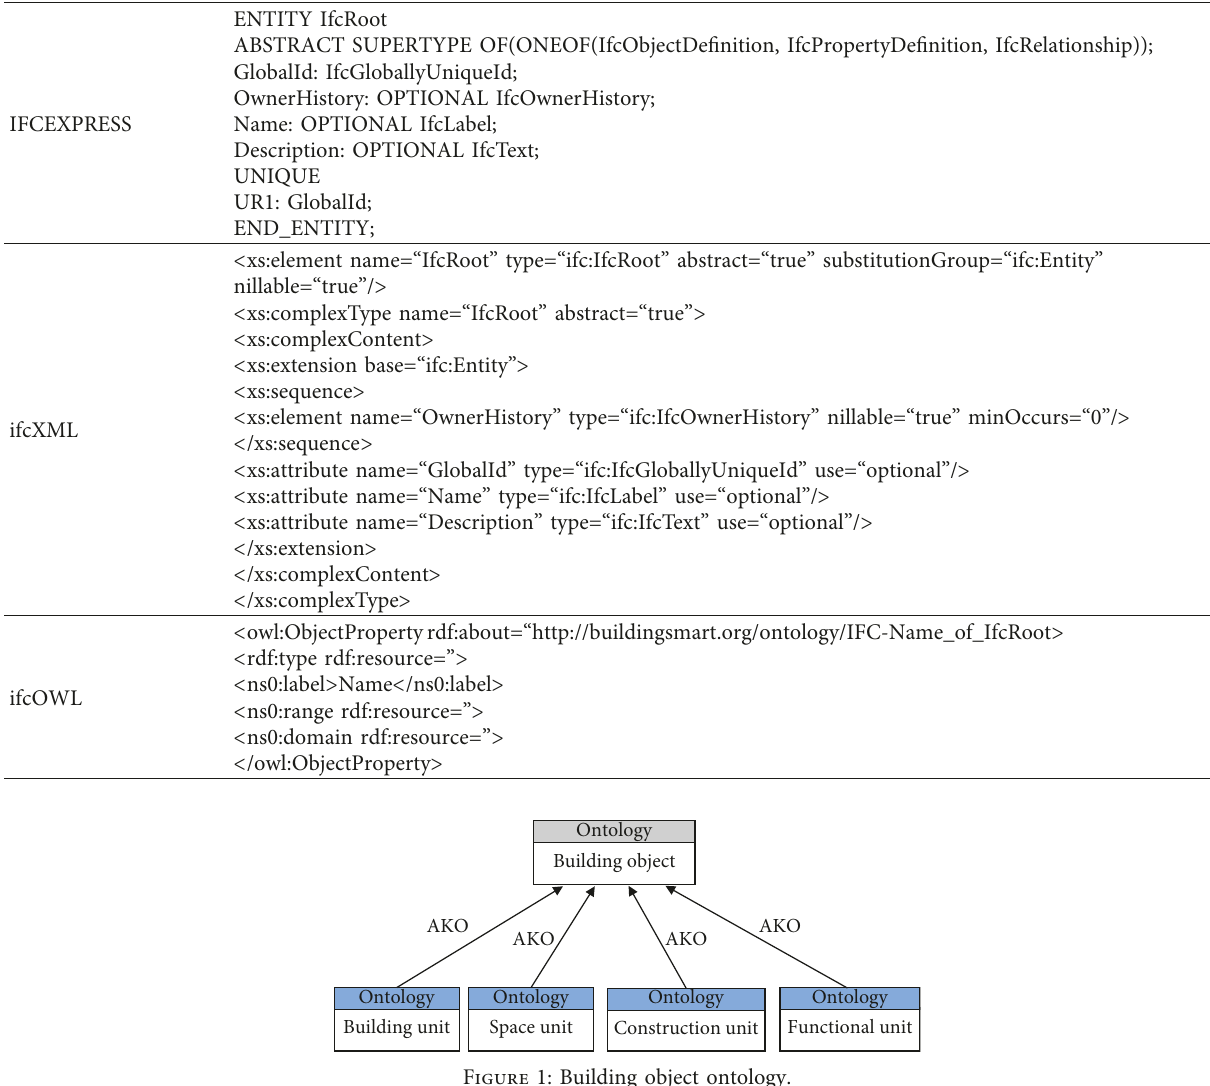
Table 1: IFCEXPRESS, ifcXML, and ifcOWL [21].